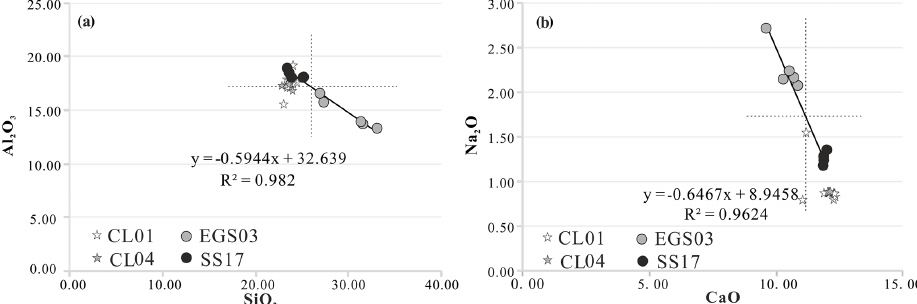
Figure 5. Correlation diagrams of Al 2 O 3 versus SiO 2 and Na 2 O versus CaO of Changle rhönite from samples SS17 and EGS03 (stars indicate rhönite from samples CL01 and CL04 for comparison). Dashed lines emphasize that the different sample populations can be distin- guished on the basis of the contents of Al 2 O 3 , SiO 2 , Na 2 O and